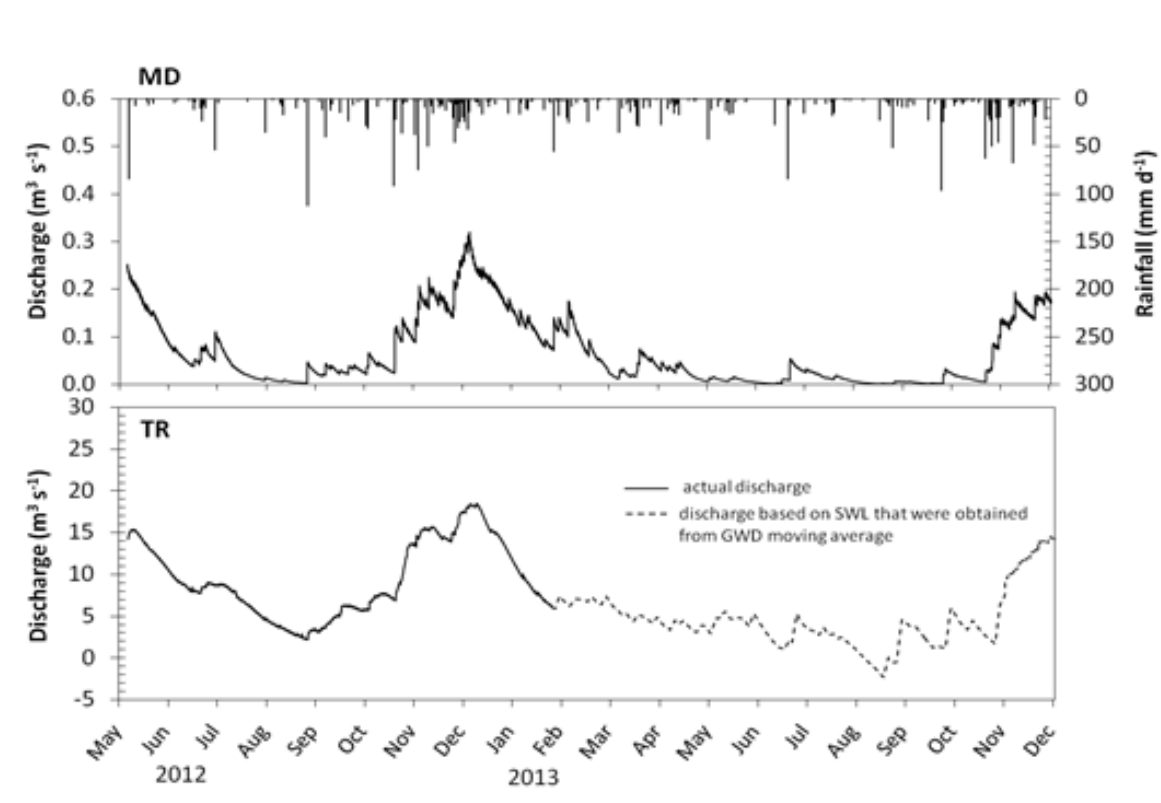
Figure 4. Discharge from Meranti Ditch (MD) and Turip River